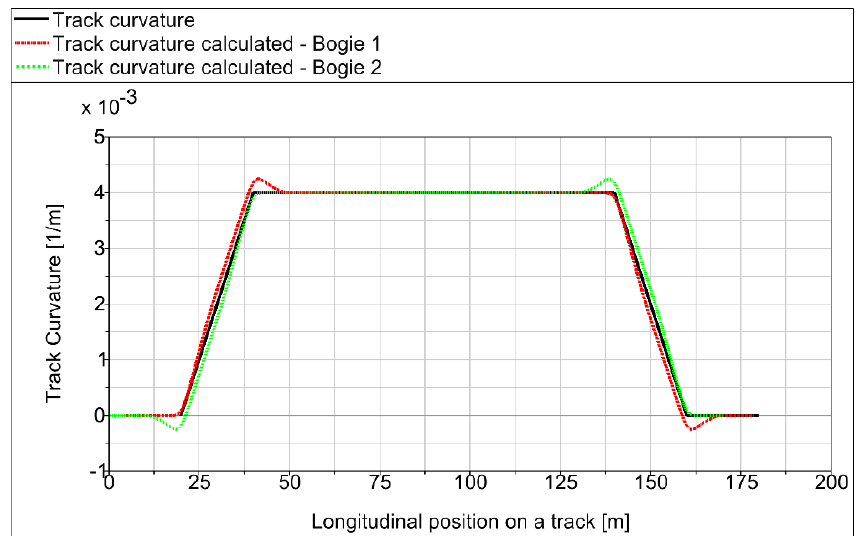
8 of 21 Figure 7. Track curvature estimated by bogie to car body rotation. This phenomenon could be considerably eliminated by the method proposed in [18]. The method utilizes not only the angle of bogie rotation towards the car body 𝛼 , but also its derivative: